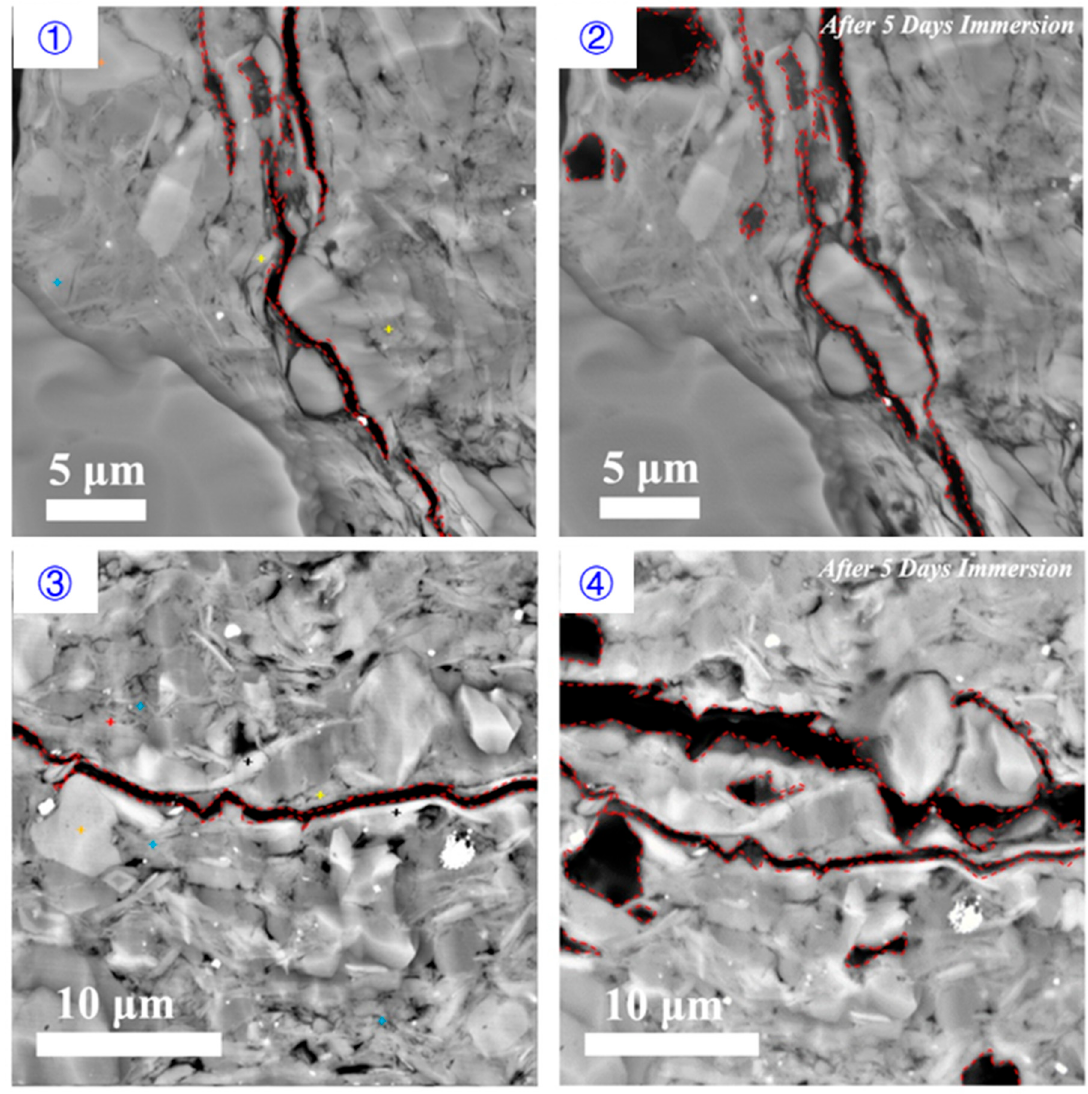
Figure 8. Micro-fracture variations before and after ( a ) 1 day’s, ( b ) 3 days’ and ( c ) 5 days’ saturation with the temperature of 80 and 120 °C, respectively.